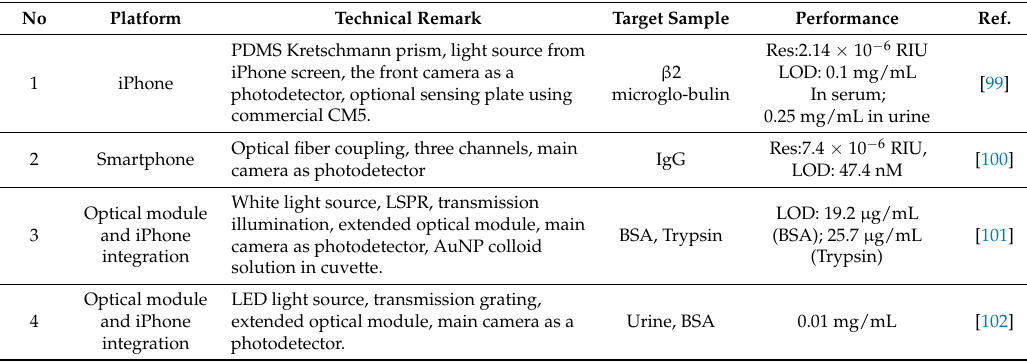
Table 6. The summary of smartphone-based SPR sensor